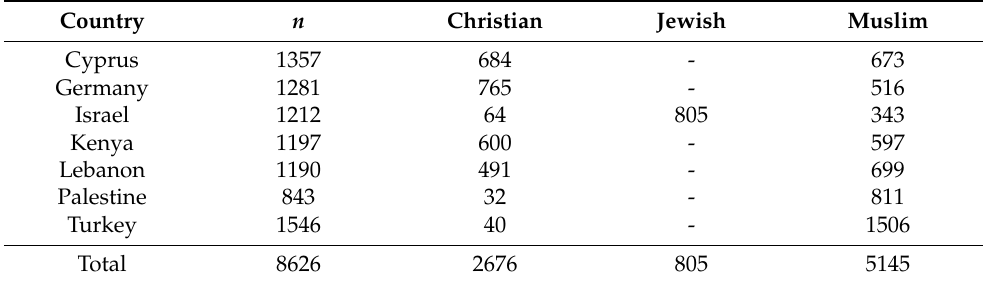
Table 1. Distribution of the sample across countries and religious